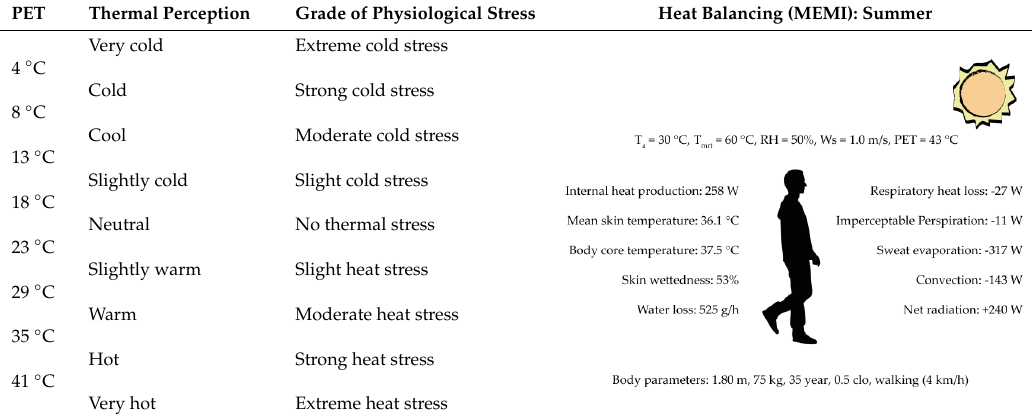
Table 3. Analysis of the current situation of the selected urban case study